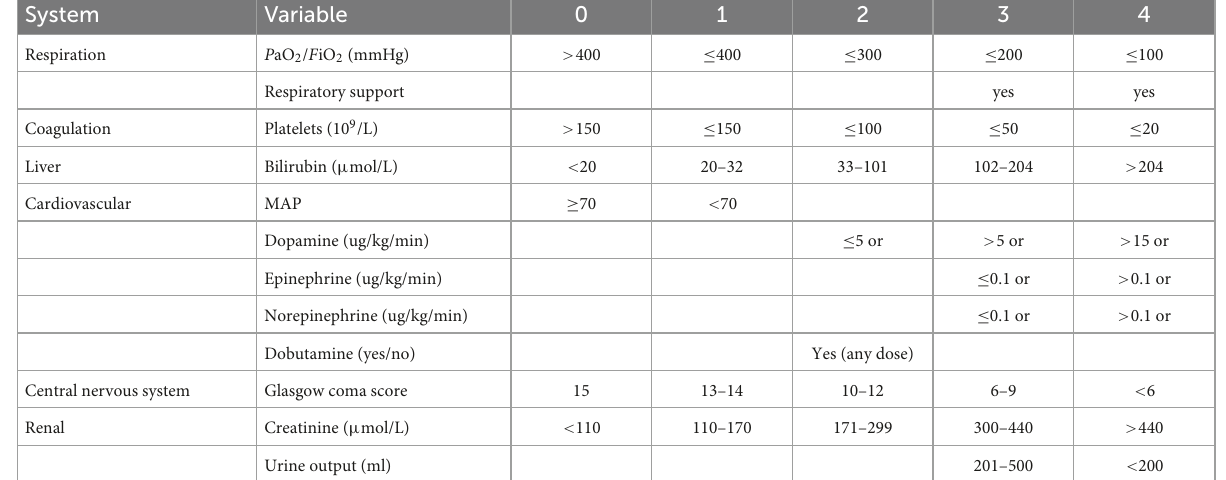
TABLE 1 Sequential organ failure